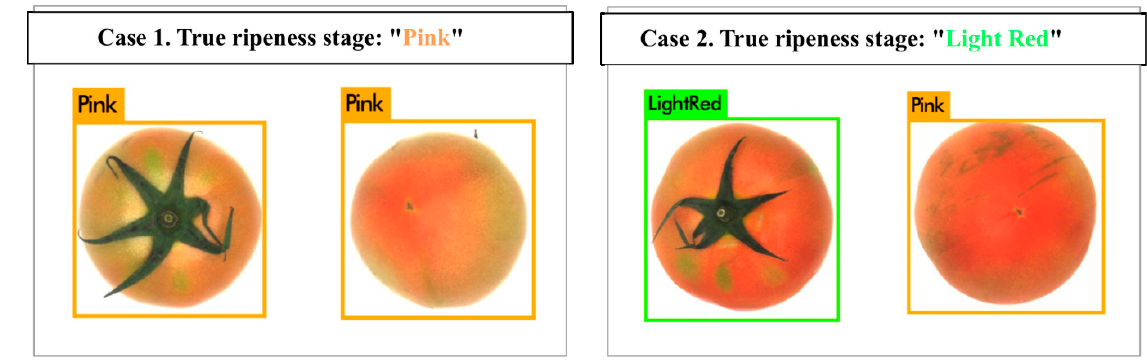
Figure 4. Examples of initial ripeness detection results of using ConvNet stream based on YOLOv3.